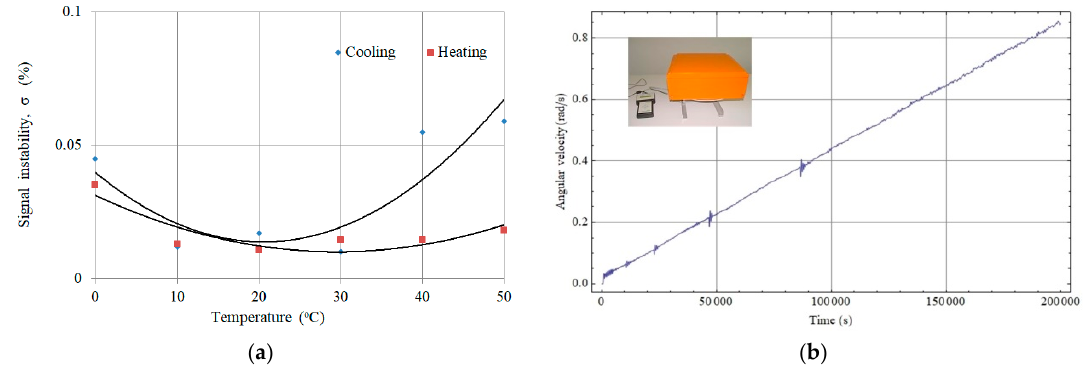
Figure 5. Example of a laboratory test of FOSREM-2: ( a ) temperature stability for the cooling and heating cycle [19], ( b ) recording rotational speed with increasing angular velocity up to 0.9 rad/s.